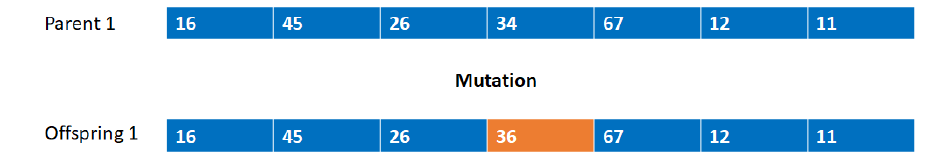
Figure 2. Basic principle of the mutation operator in